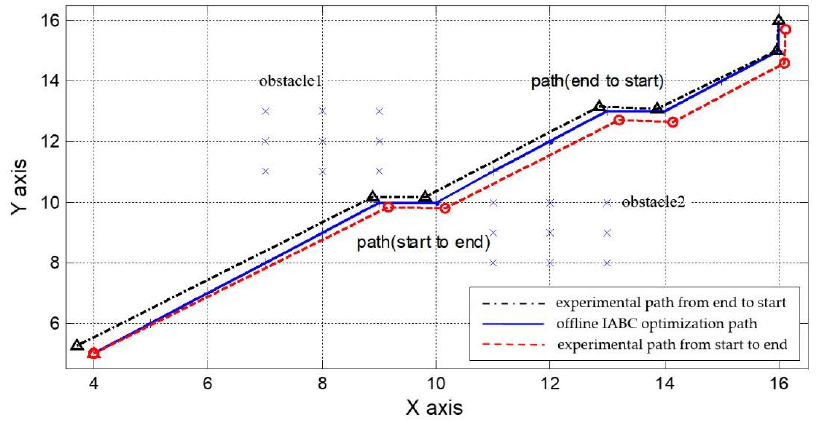
12 of 15 Table 2. Path setting for the NAO robot. Grid Coordinates